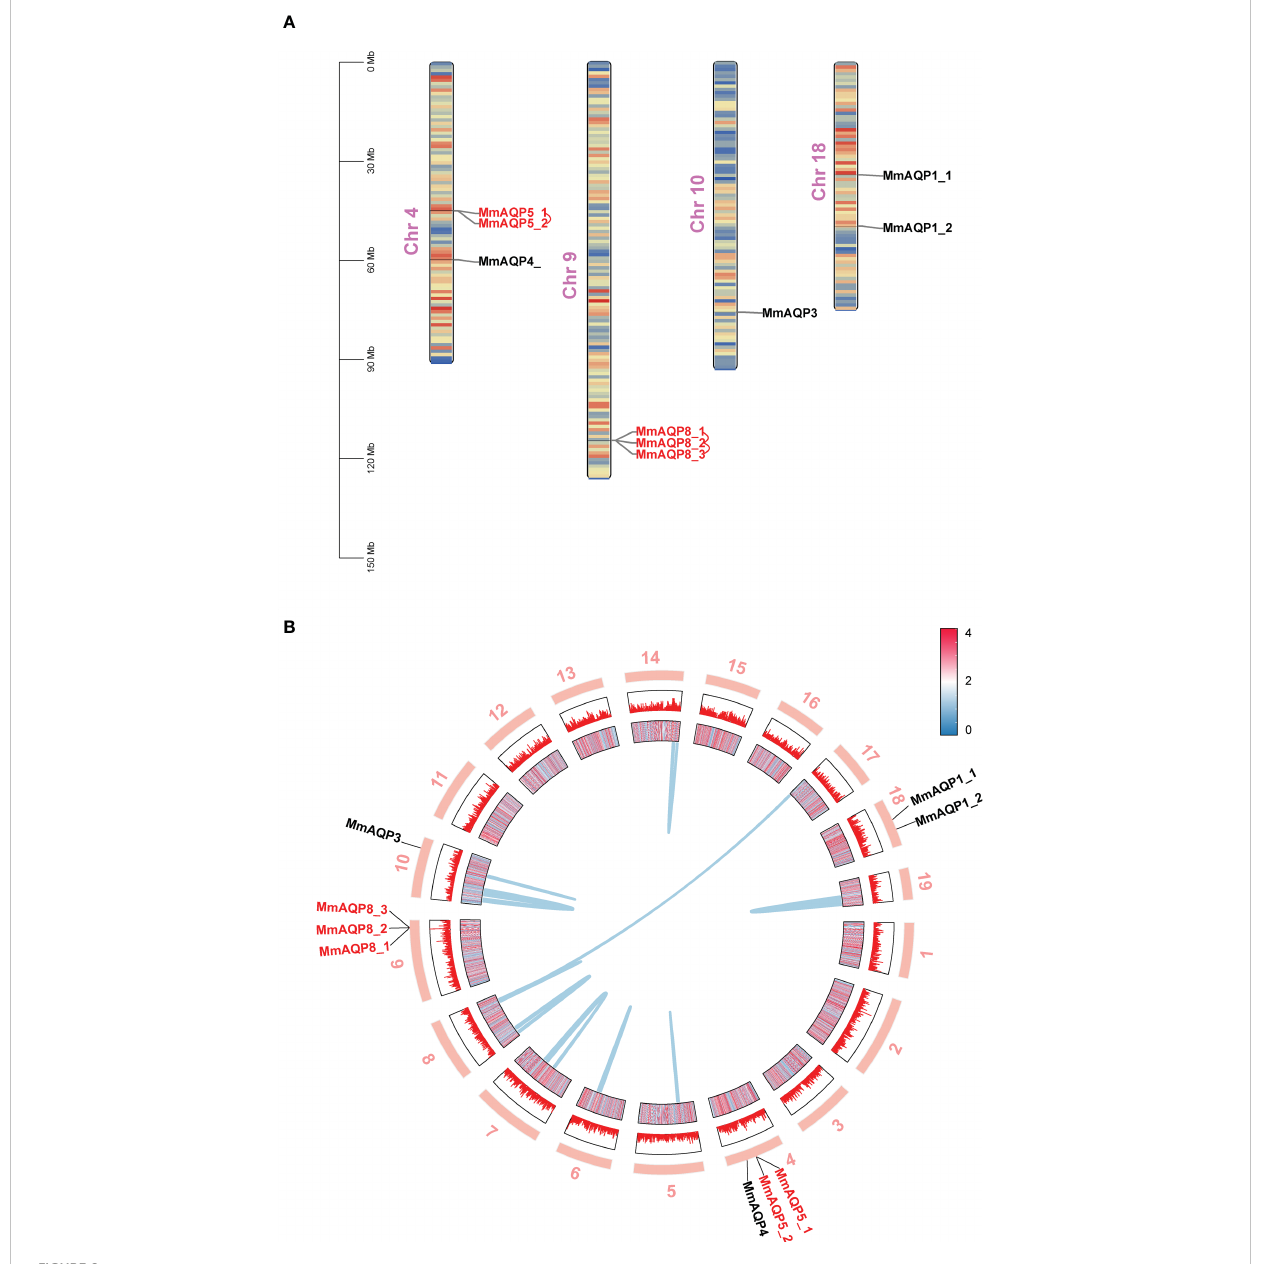
FIGURE 2 Chromosomal distribution, gene duplication and collinearity of MmAQPs. (A) Chromosome location of MmAQP genes. Tandemly-duplicated MmAQP genes are marked in red. (B) Collinear gene pairs on different chromosomes. The outer circle represents 19 chromosomes in hard clams. The inner circle represents the gene density of each chromosome. Red represents high, and blue represents low. The collinear gene pairs are linked by blue